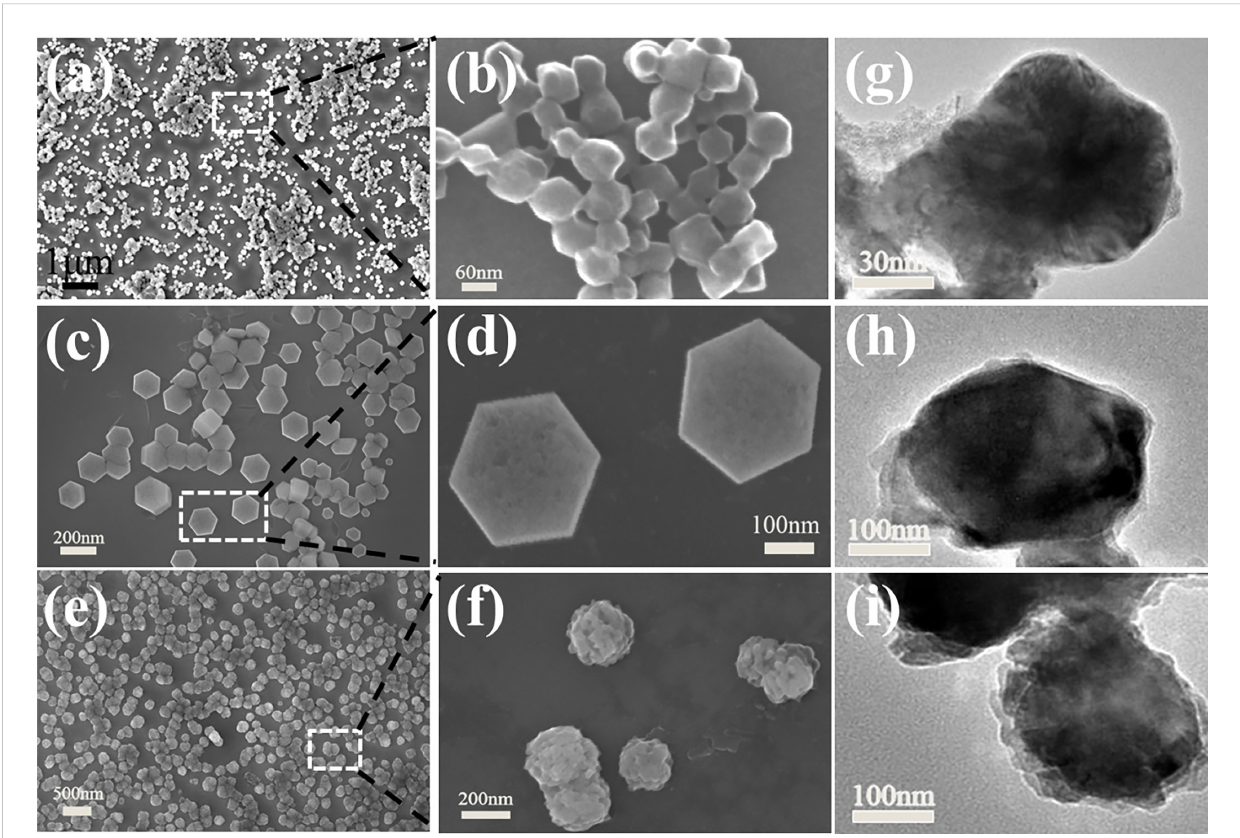
FIGURE 1 SEM of Zn-Co ZIF in (A, B) , ZD-C in (C, D) , ZD-CAR NPs in (E, F) . TEM of Zn-Co ZIF in (G) and ZD-C in (H) , and the TEM image of ZD-CAR in (I)